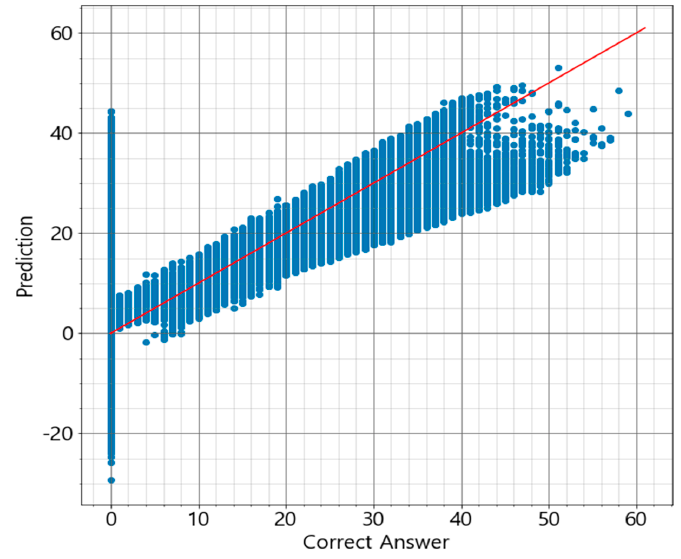
Figure 16. Prediction of sap amount based on Liner Regression.